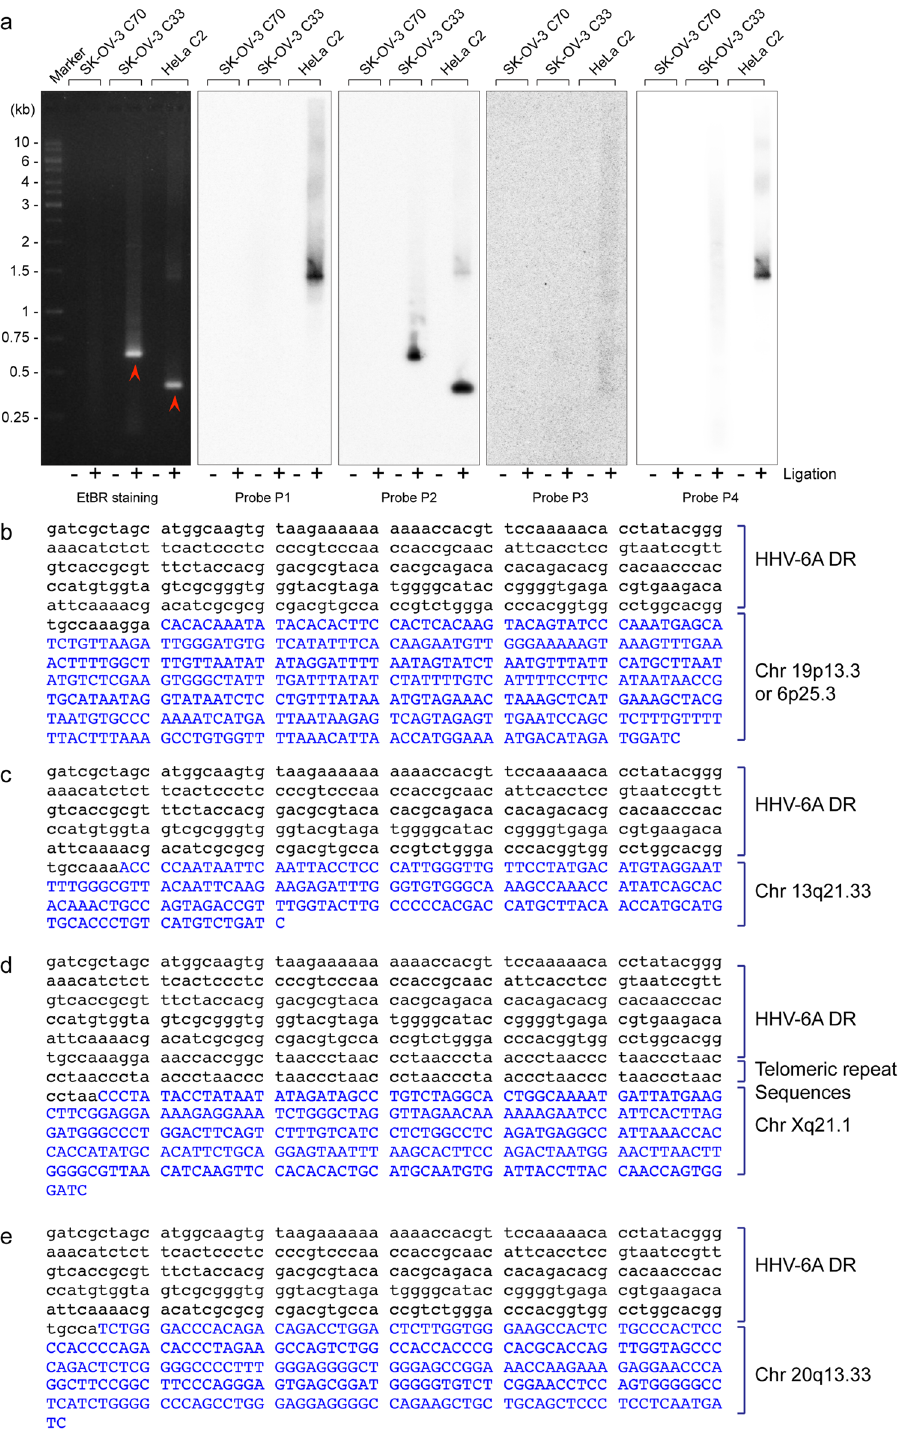
Figure 4. Non-telomeric chromosomal integration of HHV-6A. ( a ) iPCR products from three different cells were checked by Southern hybridisation using 4 different probes as explained in Fig. 3. Potential bands that did not hybridise with a telomere probe (Probe P4) are marked with red arrowhead and were processed for sequence identification. ( b – e ) Sequencing and identification of non-telomeric junction site of HHV-6A in four different clonal populations of cells. ( b ) Sequence analysis of junction site of HHV-6A in SK-OV-3 clone 33. ( c ) Sequence analysis of junction site of HHV-6A in HeLa clone 2. ( d ) Sequence analysis of junction site of HHV-6A in HeLa clone 4. ( e ) Sequence analysis of junction site of HHV-6A in U-251 clone 15. Viral DNA sequences are marked in black whereas chromosomal DNA sequences are marked in